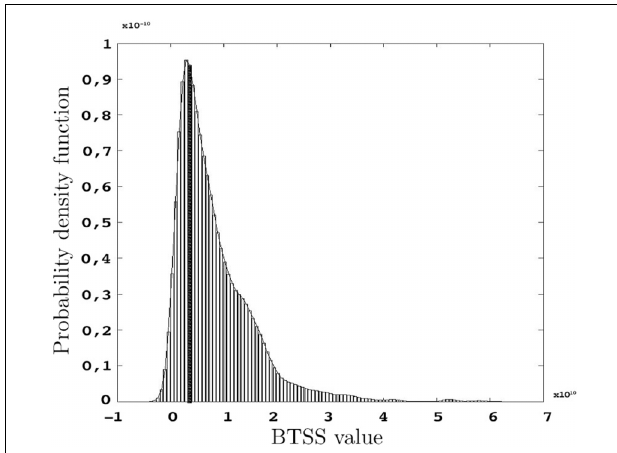
FIGURE 9 | Probability density function of BTSS for s = 1000 resamples and the observed BTSS (fi lled bar) when w ( t ) = t − 2 and t = 20, … ,60